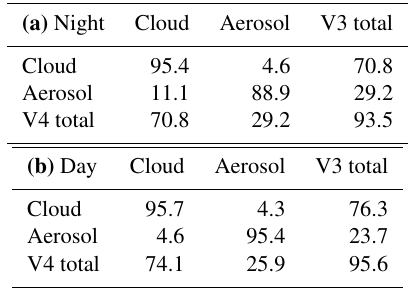
Table 3. Scene classification confusion matrices (V3 vs. V4) for the year 2008, (a) nighttime and (b) daytime. The third column of the first two rows is the fraction of the V3 cloud or aerosol relative to the total number of V3 features detected. The first two columns of the third row show the percentage of the V4 cloud or aerosol relative to the total number of V4 features